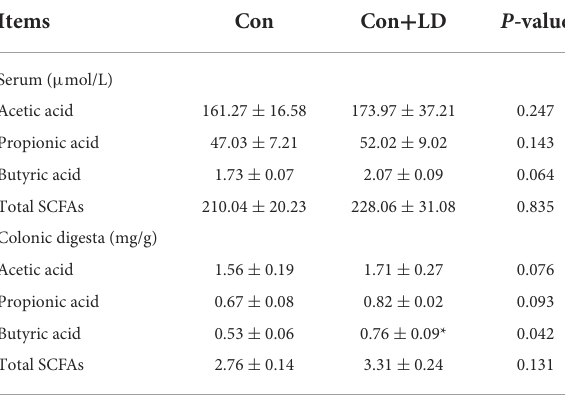
TABLE 3 Effects of L. delbrueckii on SCFA composition in the serum and colonic digesta of growing-finishing pigs.